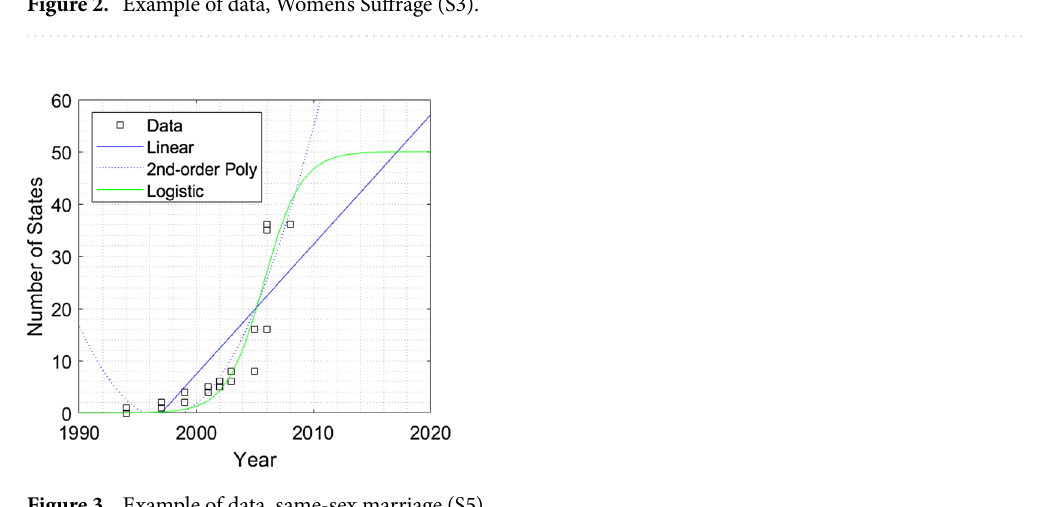
Figure 2. Example of data, Women’s Suffrage (S3).